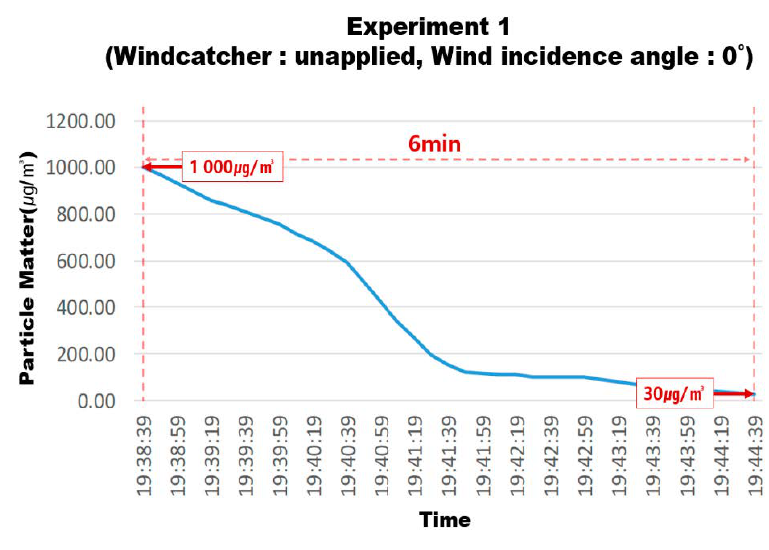
Figure 16. Results of Experiment 1.